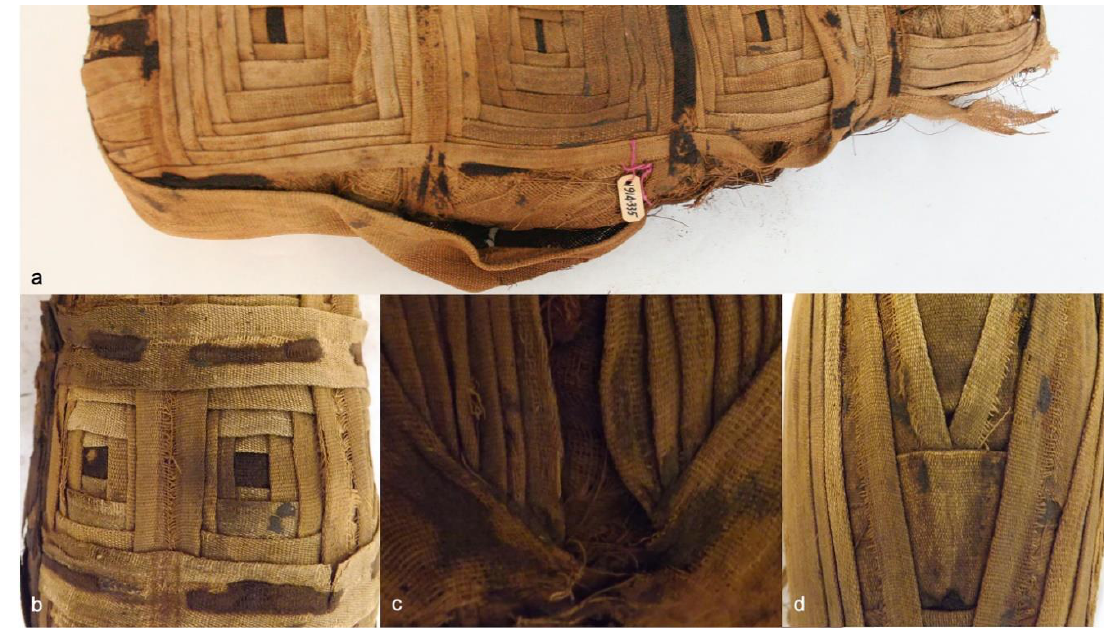
Figure 6. Photographs showing how areas of damage to mummy bundles can provide information on the construction of the elaborate wrapping styles ( a ) mummy MFA, Boston, acc. nos. 6200.4, ( b ) 6255, ( c ) RES.14.33, and ( d ) 6200.2. [Photographs taken by author.].